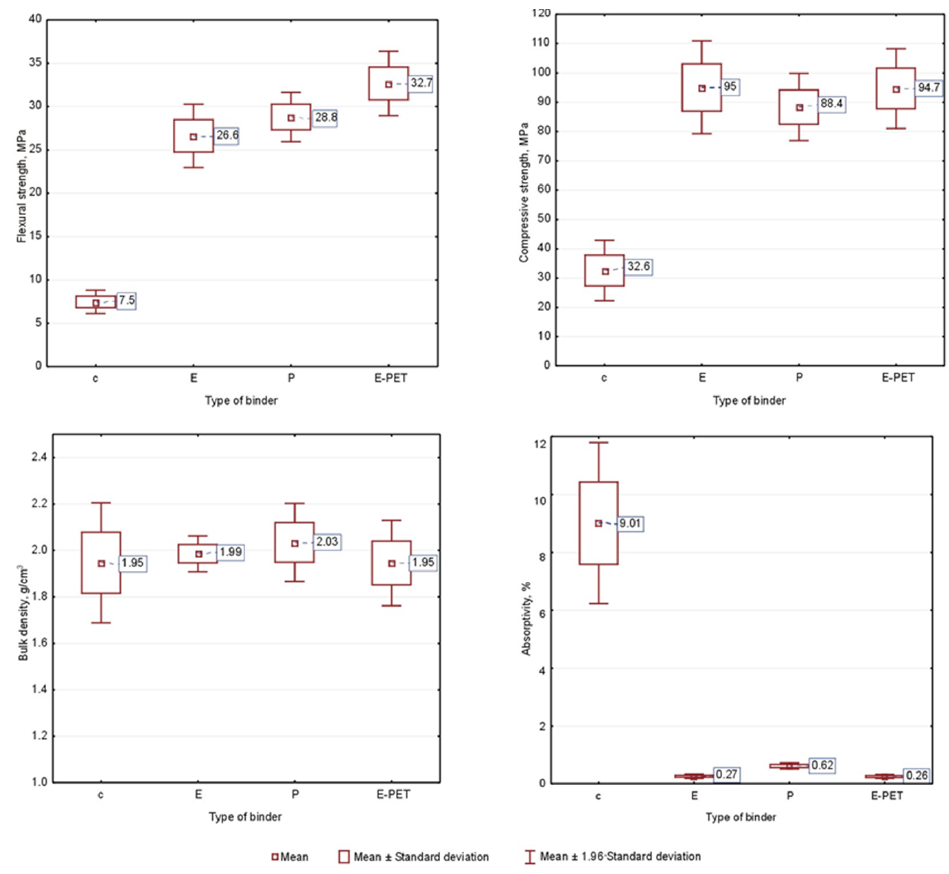
Figure 4. Descriptive statistics of marked properties of mortars.